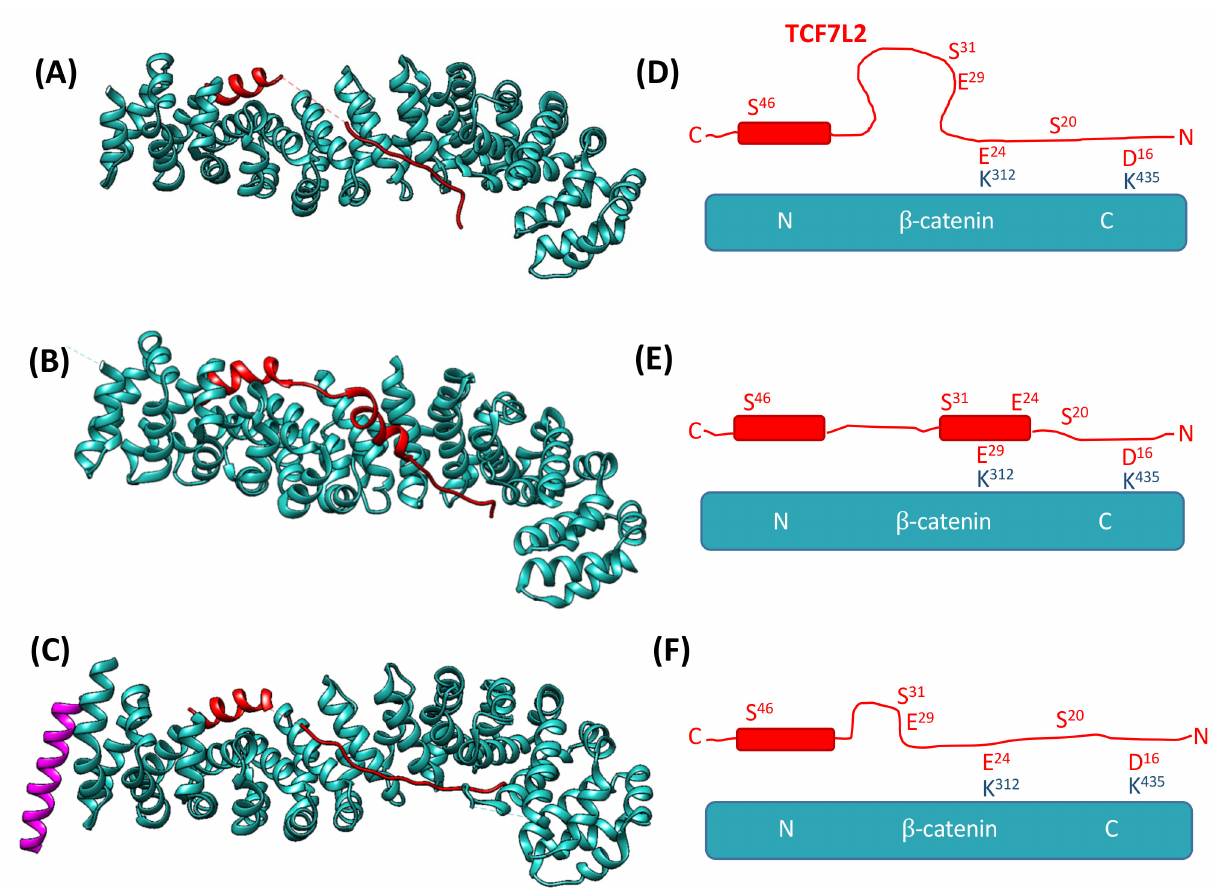
Figure 2. Schematics showing the crystal structures of the β -catenin–TCF7L2 complex. ( A – C ) show the structures of TCF7L2 (red) in complex with β -catenin (cyan) obtained by Poy et al. [22], Graham et al. [57], and Sampietro et al. [55], respectively. Structure ( C ) also has a peptide from the bound protein BCL9 (purple). ( D – F ) are schematics highlighting the different conformations of TCF7L2 between the three structures and indicating the positioning of the key contact residues within each structure. Images ( A – C ) were created using UCSF Chimera [24] from PDB 1JPW [22], 1JDH [55], and 2GL7 [25],